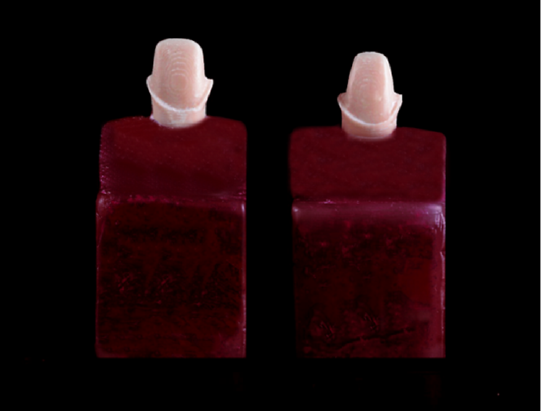
Figure 1. Two standardized all-ceramic tooth preparations with 10-degree and 20-degree total occlusal convergence angles prepared on typhodont teeth.